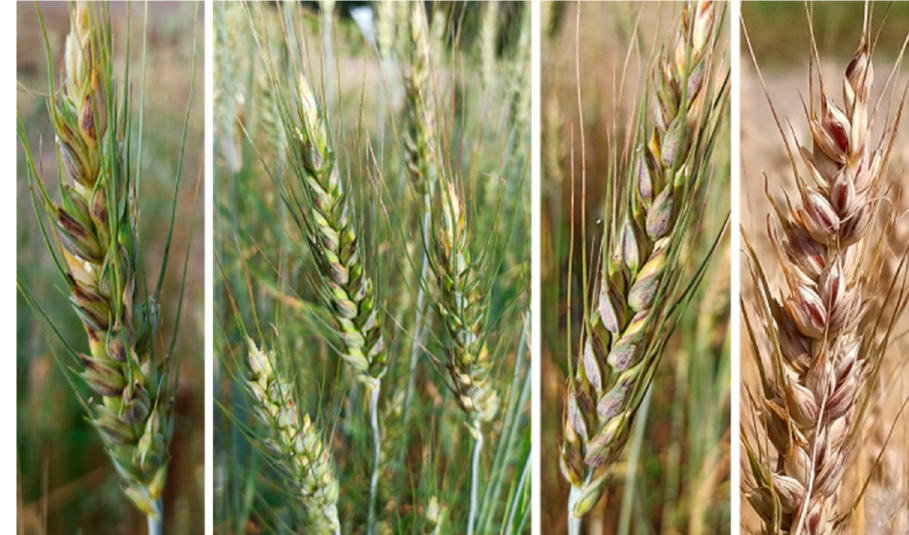
Figure A5. Brown necrosis or pseudo ‐ black chaff on the glumes of wheat spikes of the purple ‐ grained lines on BW49880 genetic background, which markers of the Sr2 ‐ complex.